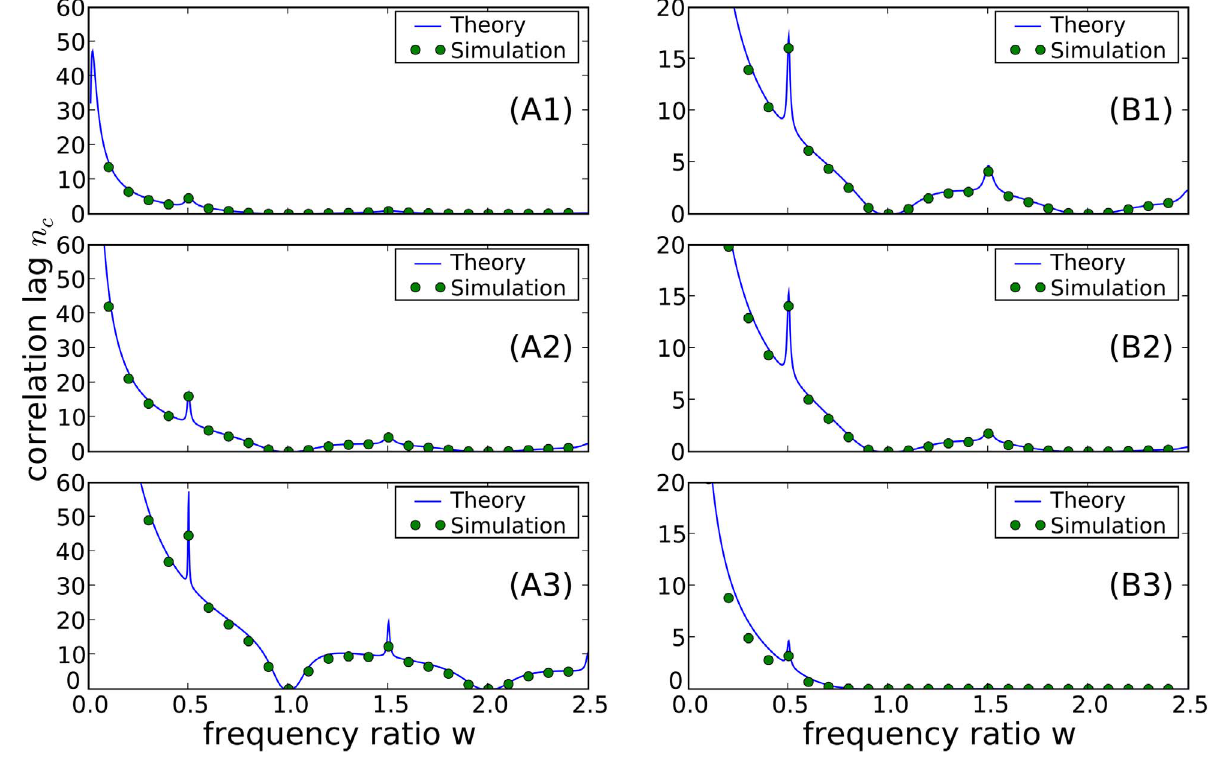
Figure 5. Correlation lag n c , in units of the mean interspike interval, as a function of the frequency ratio w . Dots show results of numerical simulations; blue lines show theory according to analytical evaluation of the sum Eq.(14). A : Correlation lag for different values of the quality factor of harmonic noise input: Q ~ 10 (A1), Q ~ 30 (A2), and Q ~ 100 (A3). Parameters: ^ ss x ~ 0 : 1 , and ^ ss z ~ 0 . B : Correlation lag at different levels of OU broadband noise: ^ ss z ~ 0 (B1), ^ ss z ~ 0 : 05 (B2), and ^ ss z ~ 0 : 2 (B3). Parameters: ^ ss x ~ 0 : 1 , Q ~ 30 , and ^ tt ~ 0 : 05 .